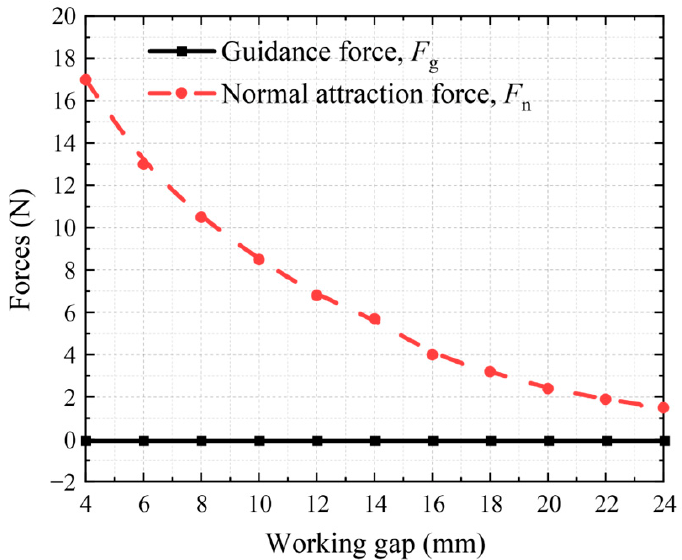
Figure 20. The experimental results of normal attraction force and guidance force at different working gaps.